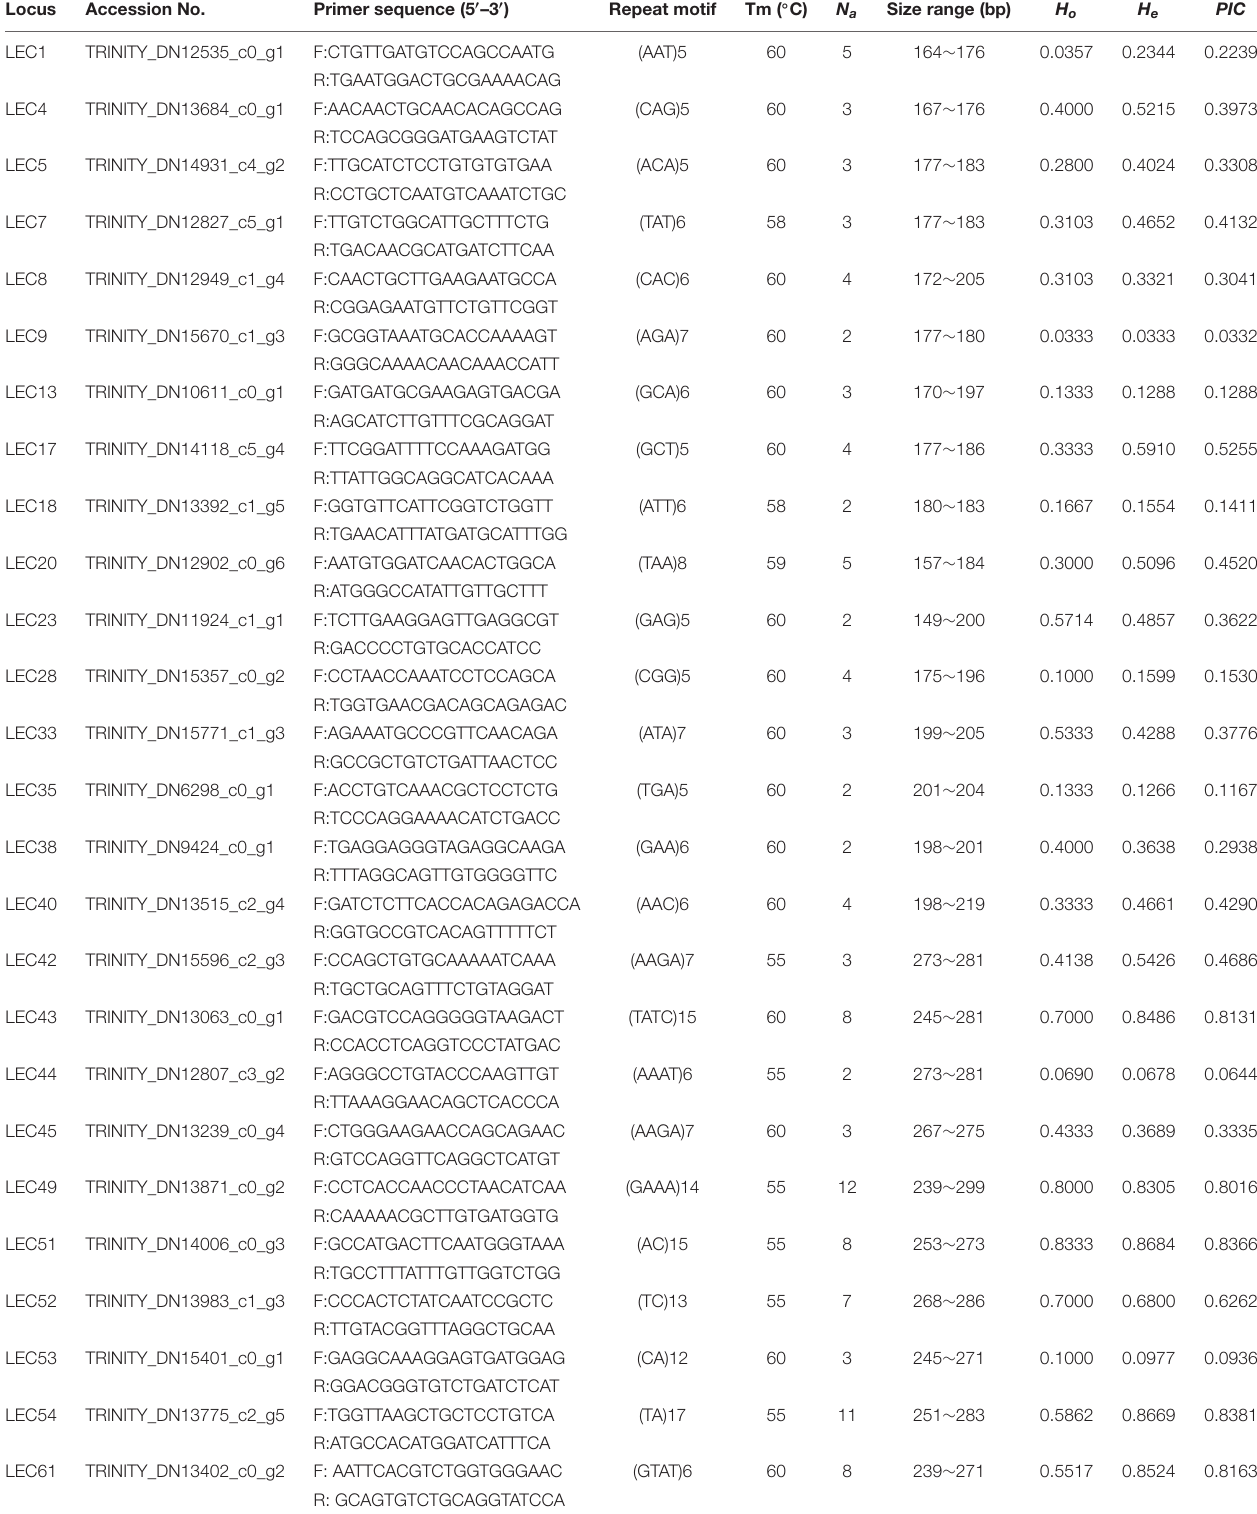
TABLE 5 | Characteristics of 52 EST-SSRs that amplified successfully and exhibited polymorphism in elongate loach. Locus Accession